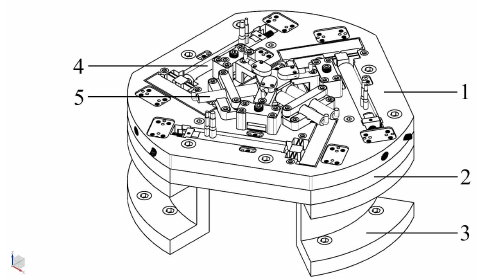
Figure 7. Proposed 6-RRRR NPS mainly using the 6-RRRR CPM. 1: Upper sub-structure; 2: connect- ing plate between the two sub-structures; 3: connecting plate between the NPS and the vibration- isolation table; 4: actuators; 5: